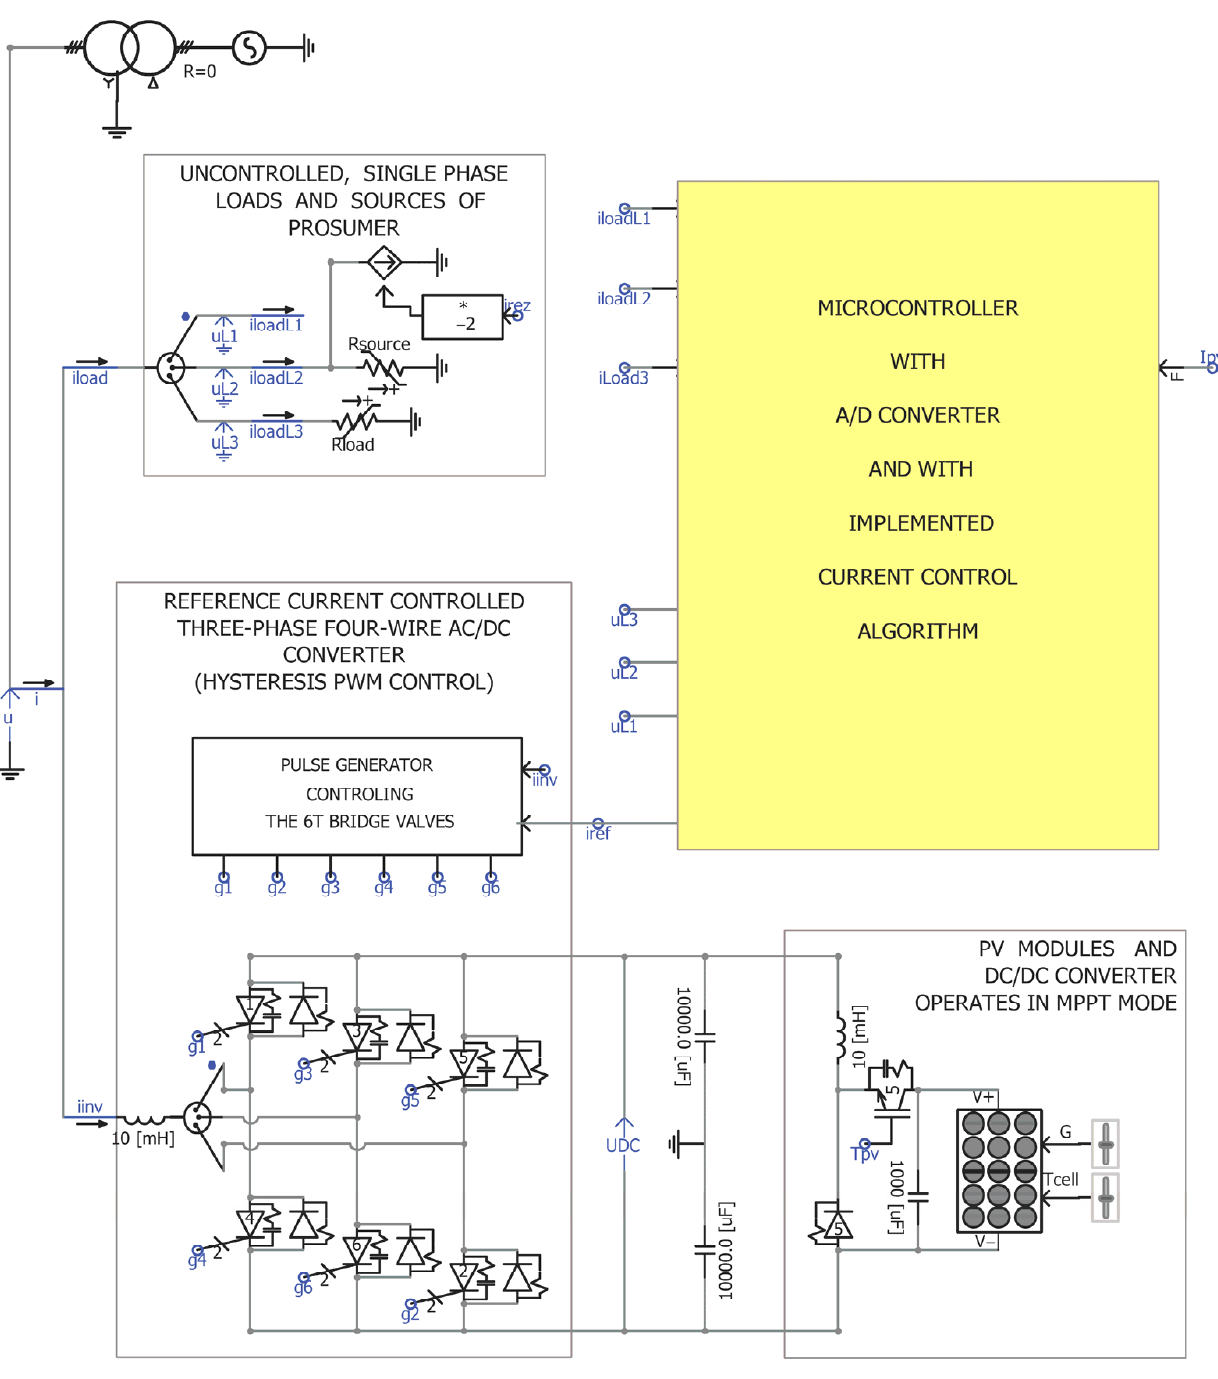
Figure 3. Diagram of prosumer installation with PV inverter controlled by the proposed algorithm. The flowchart of the presented PV inverter control algorithm is presented in Figure 4. Load and PV profiles used in simulations are shown in Figure